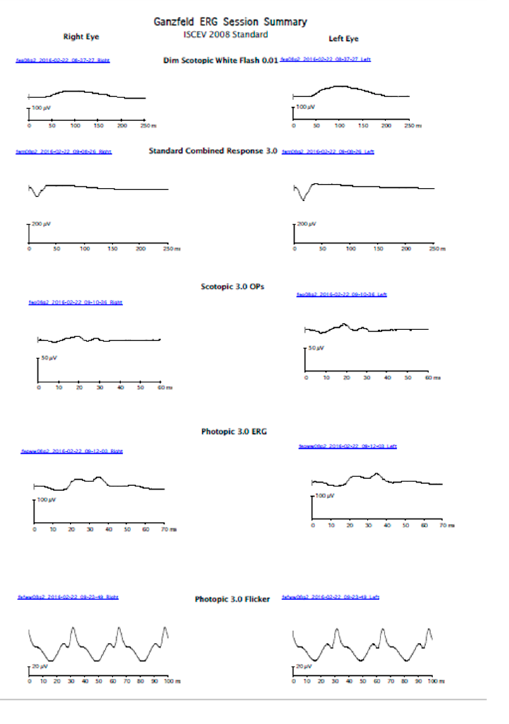
( b ) Figure 3. Optical coherence tomography (OCT) of the right ( a ) and left ( b ) macula of the child shows formed fovea in both eyes (black arrows) and a thin retinal neuron fiber layer (white arrows). Table 1. Summary of previous cases of patients with compound heterozygous optic atrophy 1 ( OPA1 ) pathogenic variants mo—months; y—years; M—male; F—female. Refer- ence